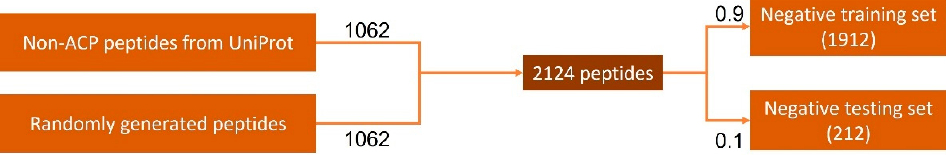
Figure 4. Negative data collection and division process.